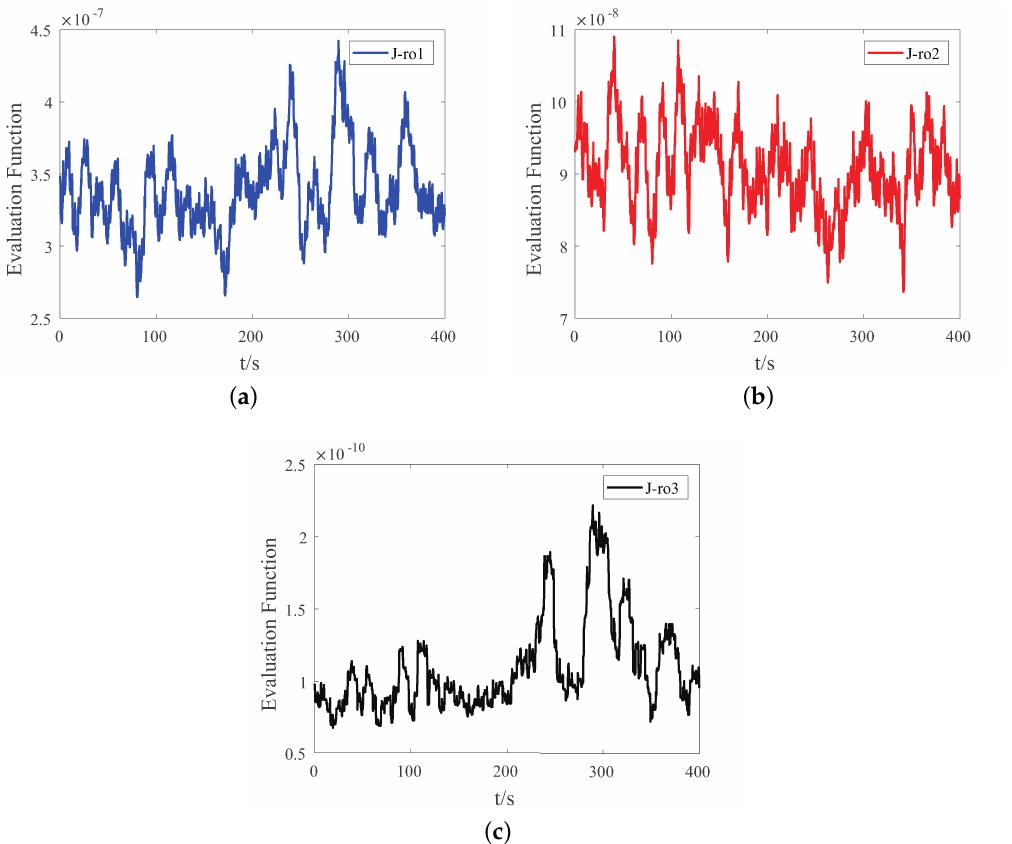
Figure 8. Simulation results of robust observer with fault modes i = 3 occurring at 200 s: ( a ) evaluation function of the first robust observer; ( b ) evaluation function of the second robust observer; ( c ) evaluation function of the third robust observer.